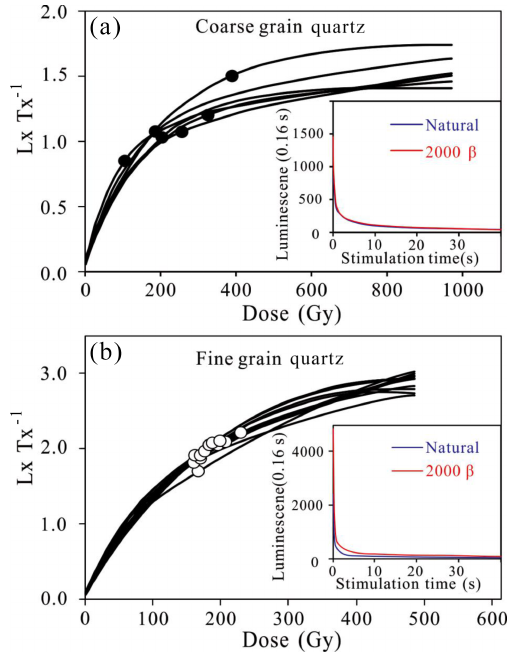
Figure 2. The OSL dose–response and decay curves of the coarse- and fine-grain quartz aliquots. Inserts show decay curves of the nat- ural and regenerated dose (2000 β ) of the sample.